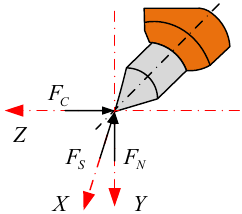
Figure 1. Force on a single pick.